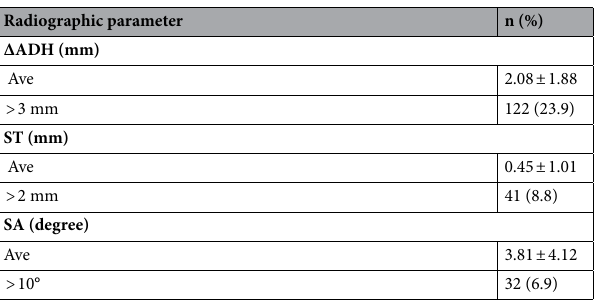
Table 2. Average values of ΔADH and ST and SA, and the percentage of intervertebral disc defined as excessive motion (instability). The excessive motion (instability) was defined as following; ΔADH > 3 mm, ST > 2 mm and SA > 10 degree. ADH, anterior disc height; ST, sagittal translation; SA, sagittal angulation.